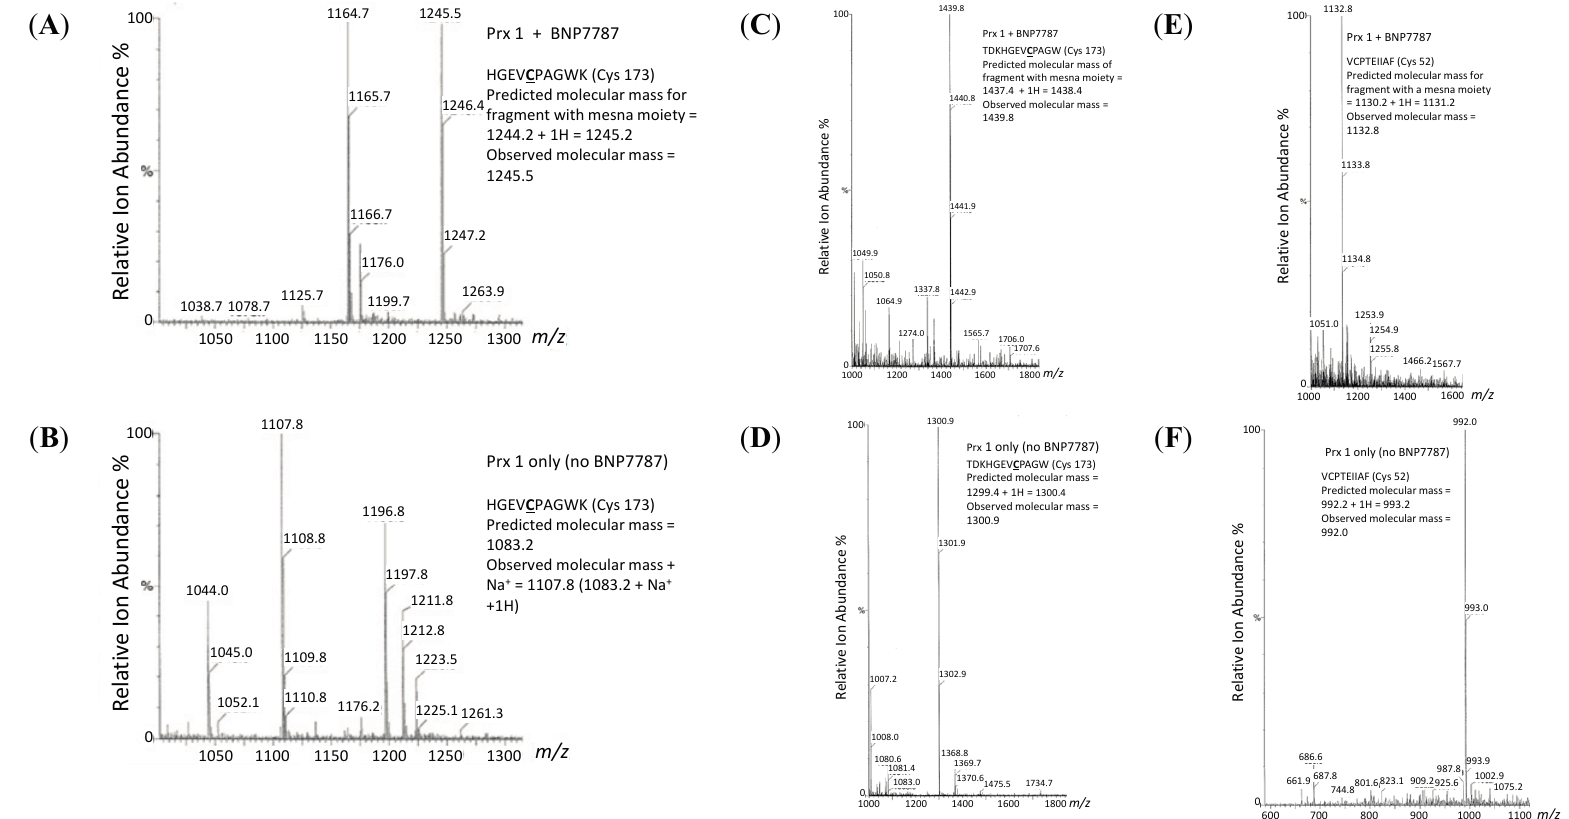
Figure 4. Representative positive ion ES mass spectrometry data for Prx 1 incubated with or without BNP7787. ( A ) Tryptic fragment of Prx 1 incubated with BNP7787 showing ion at m/z 1245.5 corresponding to fragment [HGEV C PAGWK + H]+ with BNP7787-derived adduct on Cys 173; ( B ) Tryptic fragment of Prx 1 incubated without BNP7787 did not have ion at m/z 1245.5 and was not modified on Cys 173; ( C ) Chymotryptic fragment TDKHGEV C PAGW of Prx 1 incubated with BNP7787 also showing BNP7787-derived adduct on Cys 173 of peroxiredoxin; ( D ) Chymotryptic fragment of Prx 1 incubated without BNP7787 was not modified on Cys 173 of Prx 1; ( E ) Chymotryptic fragment V C PTEIIAF of Prx 1 incubated with BNP7787 showing BNP7787 derived adduct on Cys 52 of Prx 1; ( F ) Chymotryptic fragment of Prx 1 incubated without BNP7787 had no adduct on Cys 52 of Prx